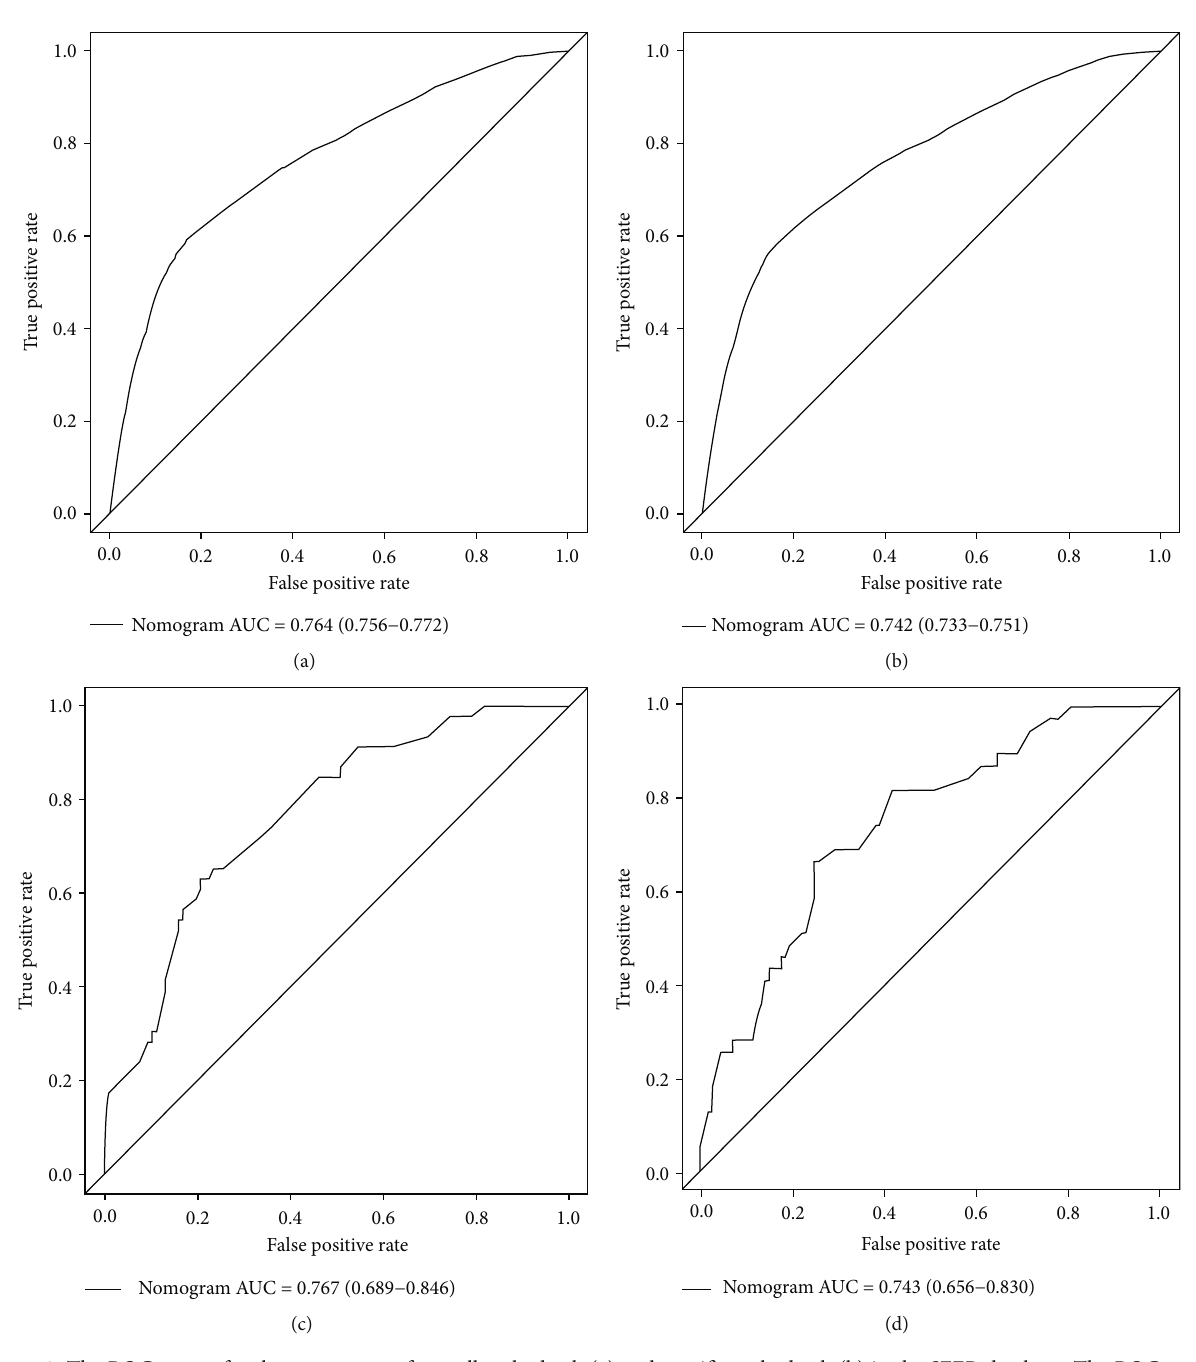
Figure 2: The ROC curves for the nomogram of overall early death (a) and speci fi c early death (b) in the SEER database. The ROC curves for the nomogram of overall early death (c) and speci fi c early death nomogram (d) in the validation